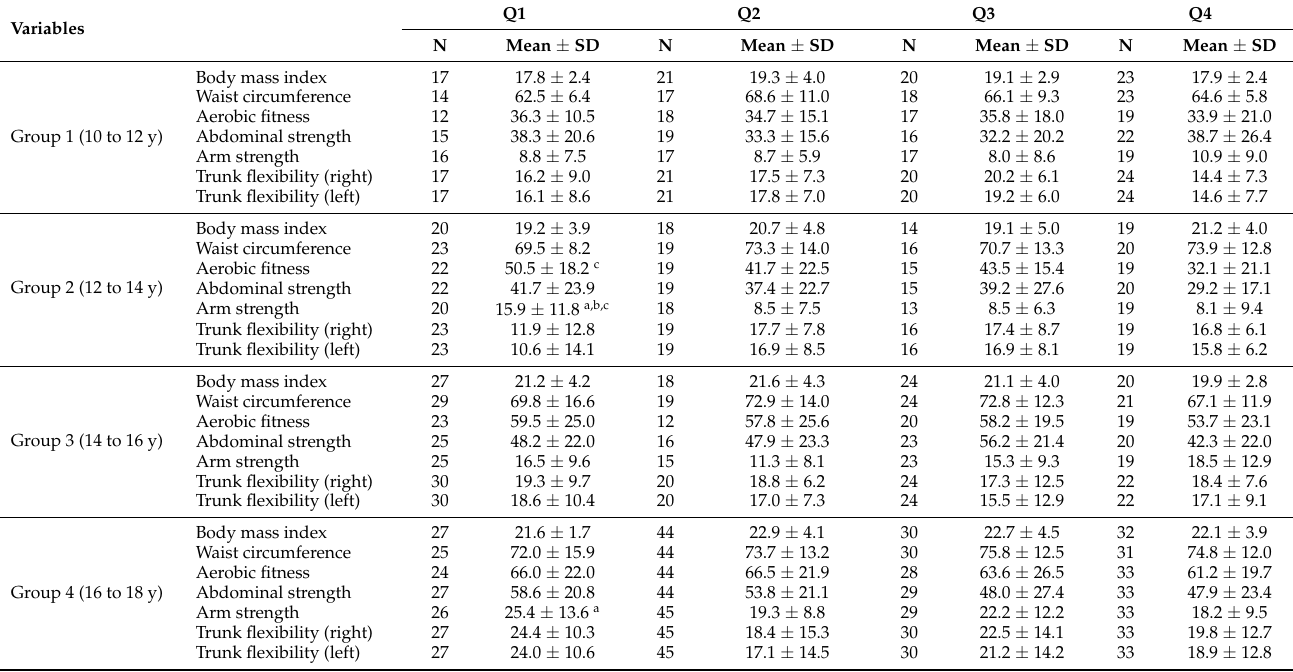
Characterization and inferential analysis of the considered variables according to the age group for male